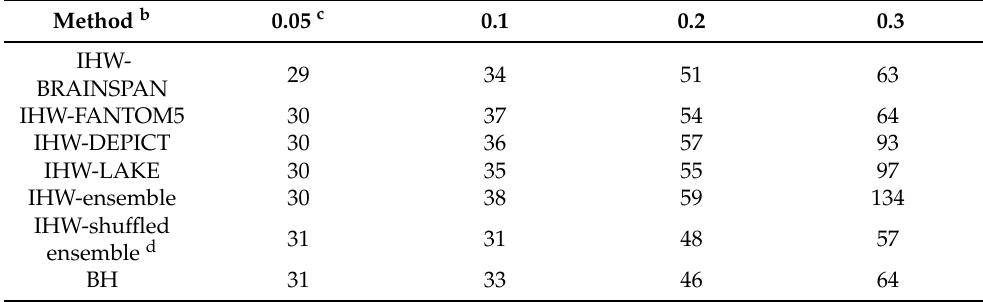
Table 2. Number of discoveries from SCZ dataset, by different methods and covariates a . Method